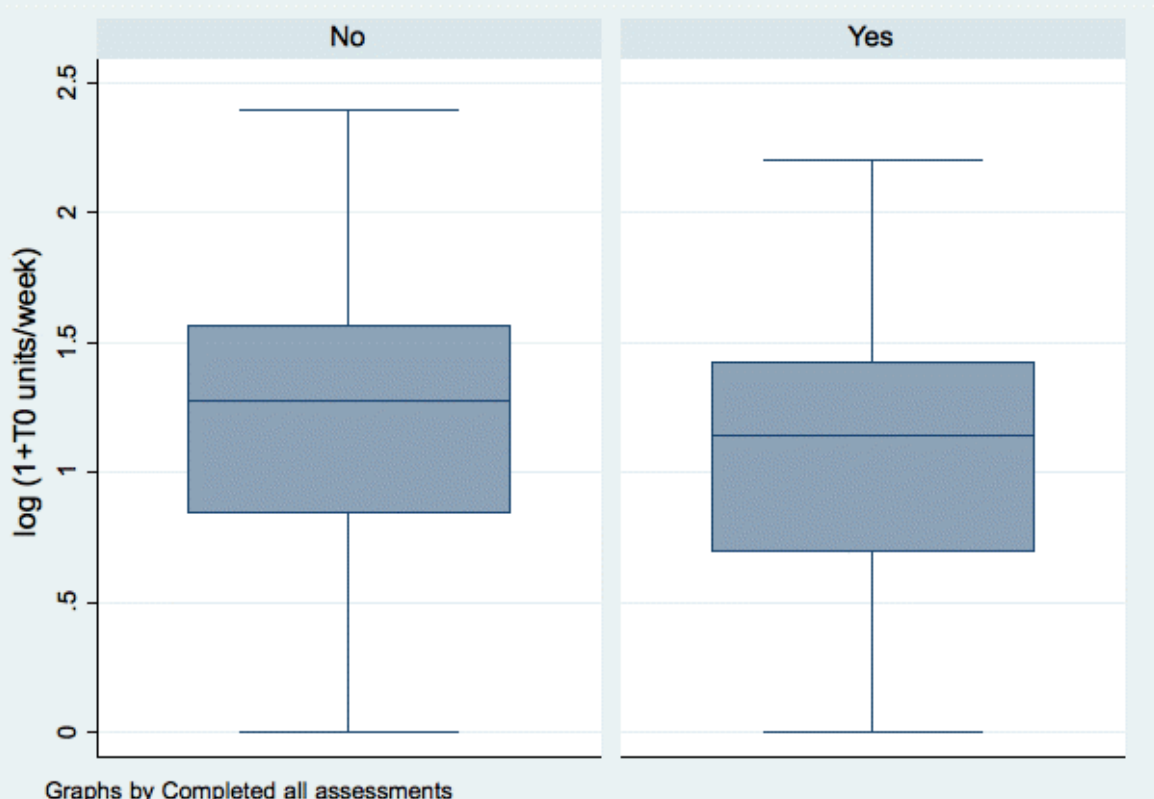
Figure 2. Average number of units of alcohol consumed over the previous week (expressed as the natural logarithm of the number of units plus 1) at baseline (Time 0) by assessment completion status